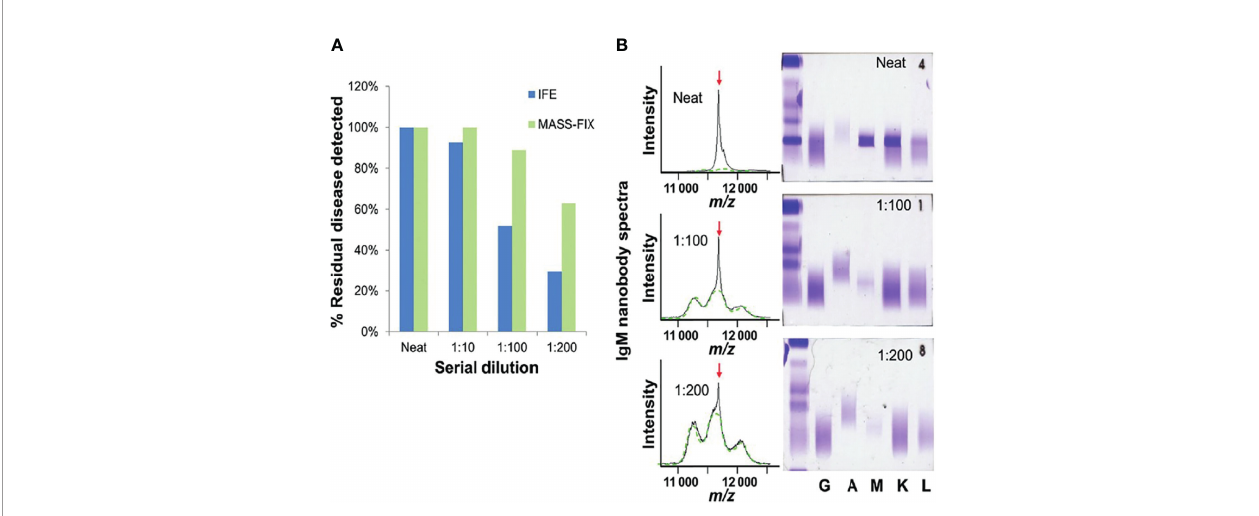
FIGURE 1 | Twenty-seven patients with dysproteinemias representing all possible isotypes (GK, DL, AK, AL, MK, ML, and free kappa and lambda) were analyzed with MASS-FIX (Mayo Clinic ’ s MALDI-TOF mass spectrometry assay) and immuno fi xation. The original sample was diluted into normal human serum and serially diluted, as shown in (A) . The gels and spectra were randomized and blindly evaluated for the presence of a monoclonal protein by two investigators with a 100% concordance rate. The bar graph in (B) demonstrates the superior analytical sensitivity of the mass spectrometry approach over immuno fi xation. A characteristic example from a monoclonal MK protein is shown on the right. A monoclonal peak is clearly discernible at a 1:200 dilution with MASS FIX but not immuno fi xation — image courtesy of Dr. David Murray, Director, Mayo Clinic Immunology